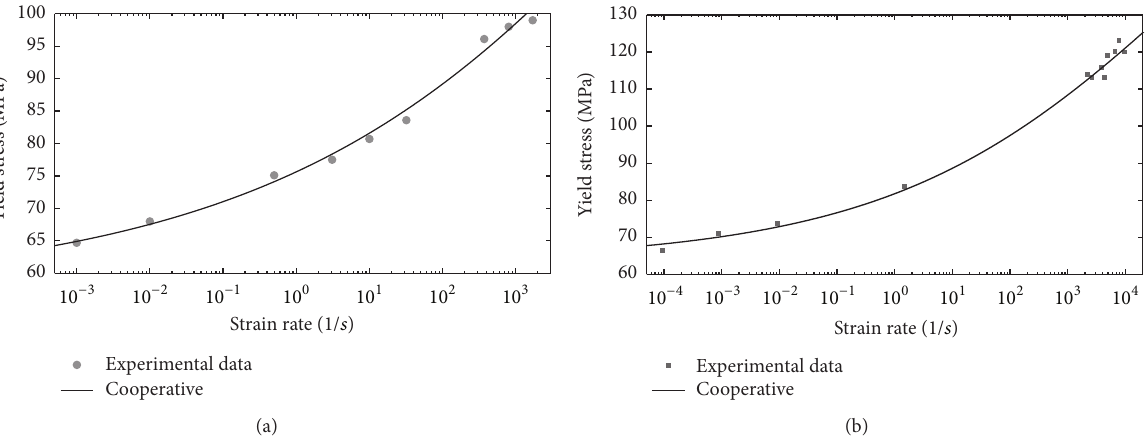
Figure 4: Experimental yield stress of PC fitted by the cooperative equation: (a) tension and (b) compression.